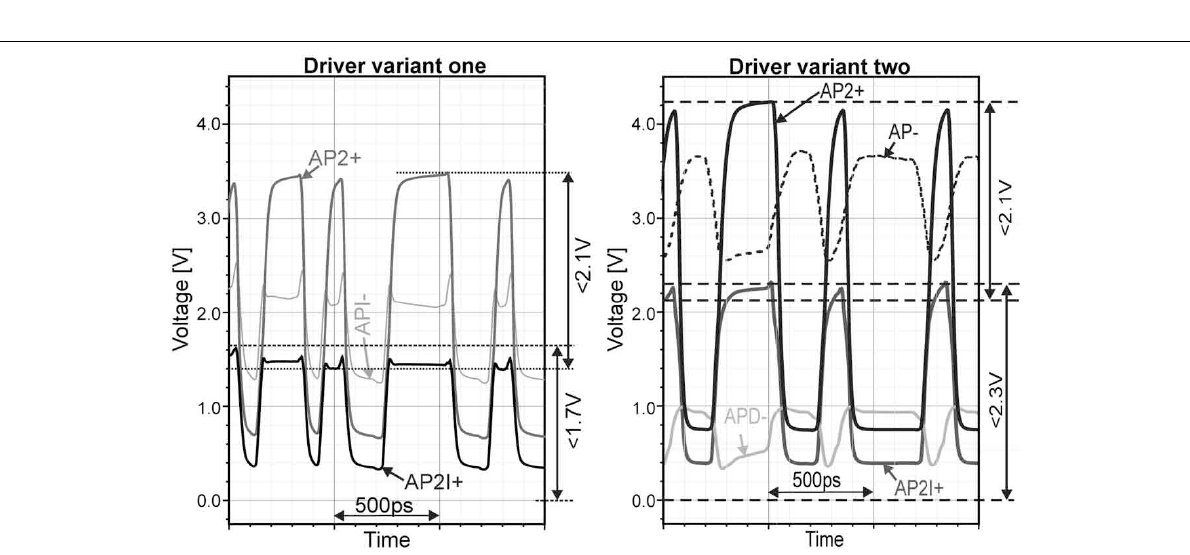
FIGURE 5 | Transient simulations of the final amplifier in the output stage. The signals for driver variant one can be found on the left side and the transients for driver variant two are depicted on the right